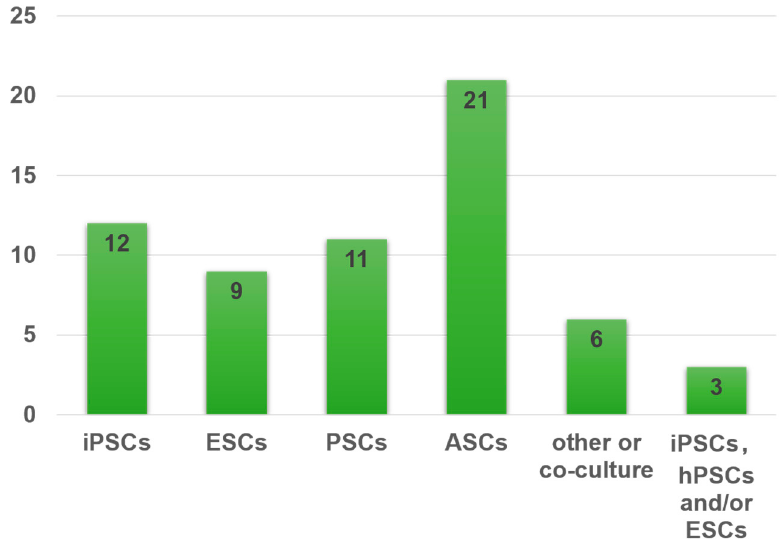
Figure 2. A histogram revealing the number of included articles using different stem cells. Abbre- viations: ASCs: adult stem cells; iPSCs: induced pluripotent stem cells; ESCs: embryonic stem cells; PSCs: pluripotent stem cells.